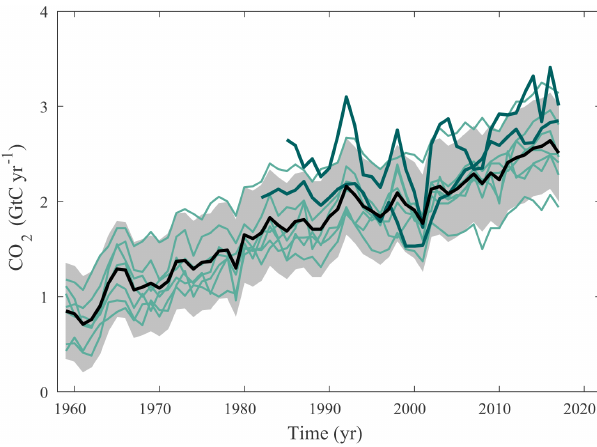
Figure 7. Comparison of the anthropogenic atmosphere–ocean CO 2 flux showing the budget values of S OCEAN (black; with ± 1 σ uncertainty in grey shading), individual ocean models (blue), and the two ocean p CO 2 -based flux products (dark blue; see Table 4). Both p CO 2 -based flux products were adjusted for the pre-industrial ocean source of CO 2 from river input to the ocean, which is not present in the ocean models, by adding a sink of 0.78GtCyr − 1 (Re- splandy et al., 2018), to make them comparable to S OCEAN . This adjustment does not take into account the anthropogenic contribu- tion to river fluxes (see Sect.